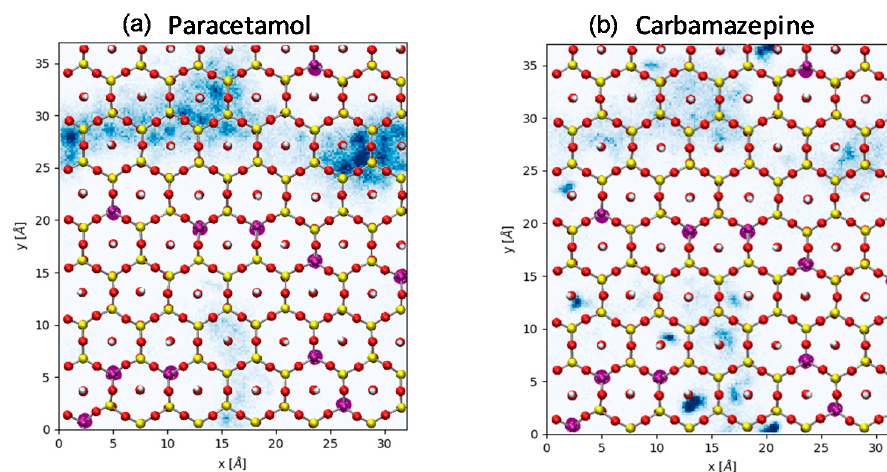
Figure 6. Saponite upper basal surface and density plots (in blue) of paracetamol ( a ) and carbamazepine ( b ) representing their position when adsorbed at the surface. Oxygen atoms are shown in red, silicium in yellow, and aluminum (tetrahedral substitutions) in purple.